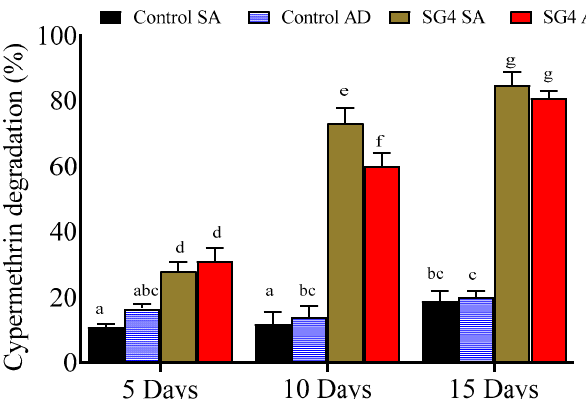
Figure 2. Effect of strain SG4 immobilization (sodium alginate and agar disc) on the degradation of cypermethrin. The data presented are mean ± standard errors of three independent experiments. Statistical analysis was performed by one way ANOVA of Duncan method, and di ff erent letters indicate significant di ff erences ( p < 0.05) between treatments. SA: sodium alginate, AD: agar discs. Table 2. Degradation kinetics of cypermethrin with immobilized culture.